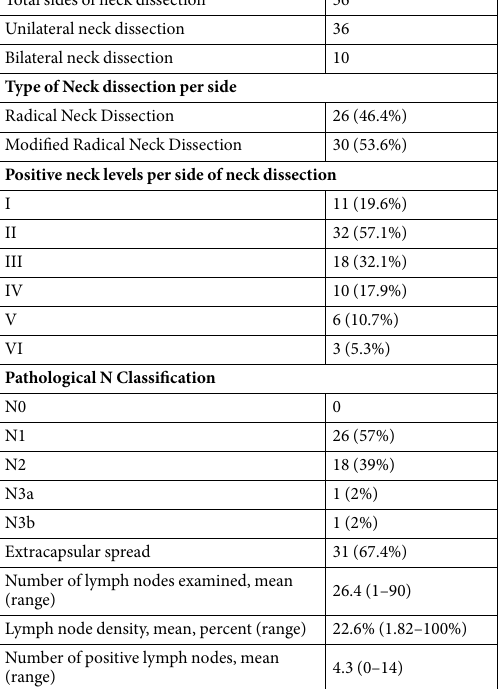
Table 2. Neck dissection specifics. This table summarizes the specifics of neck dissection of all subjects.